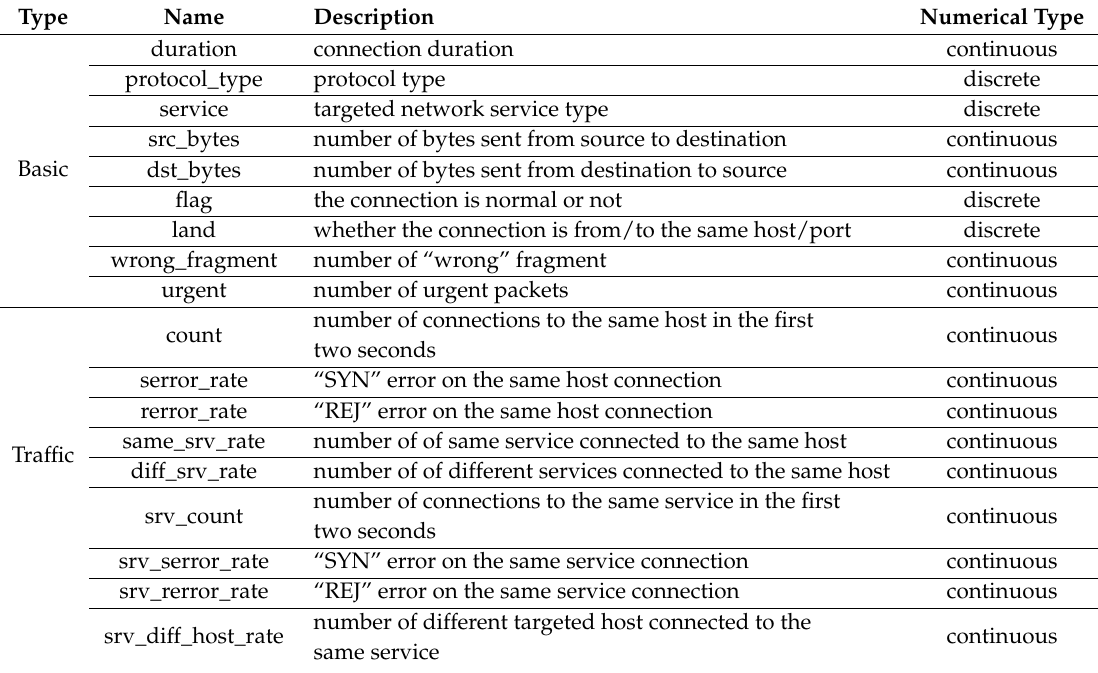
Table 2. The features of NSL-KDD used to simulate the intrusion detection system